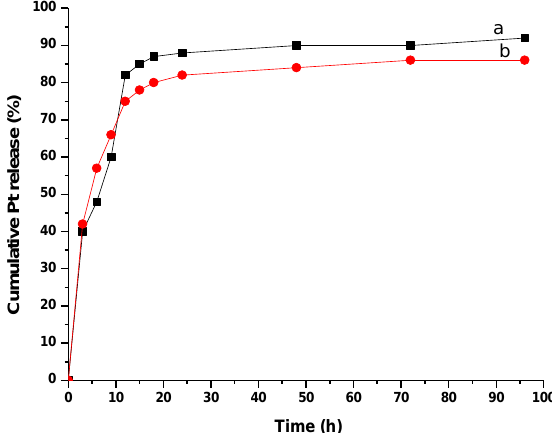
Figure 4. Pt release for MWCNT-COOH-CDDP in PBS at ( a ) 5.5 and ( b ) 7.4 pH values.